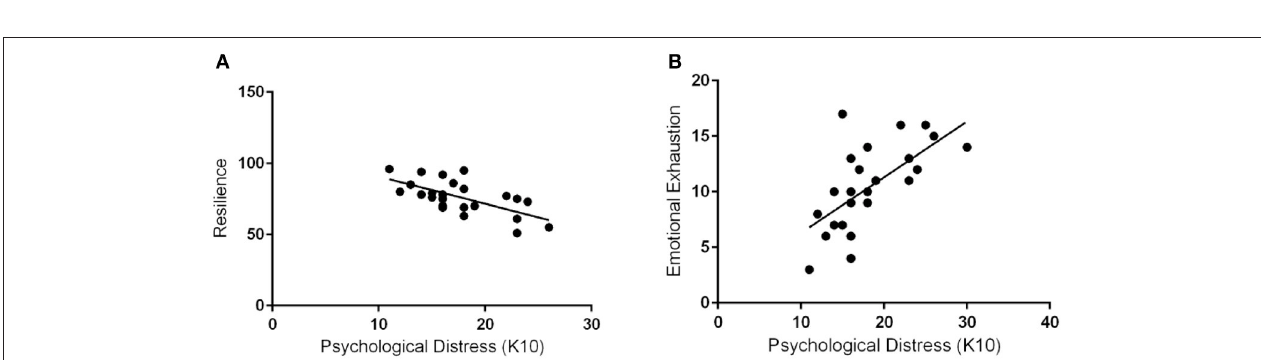
FIGURE 5 | Resilience positively correlates with personal achievement and negatively with emotional exhaustion. Resilience scores on the Resiliency Quiz correlated positively with Personal Achievement scores ( A , p < 0.001) and negatively with emotional exhaustion scores ( B , p = 0.015). The correlation with depersonalization was non-significant (C) .